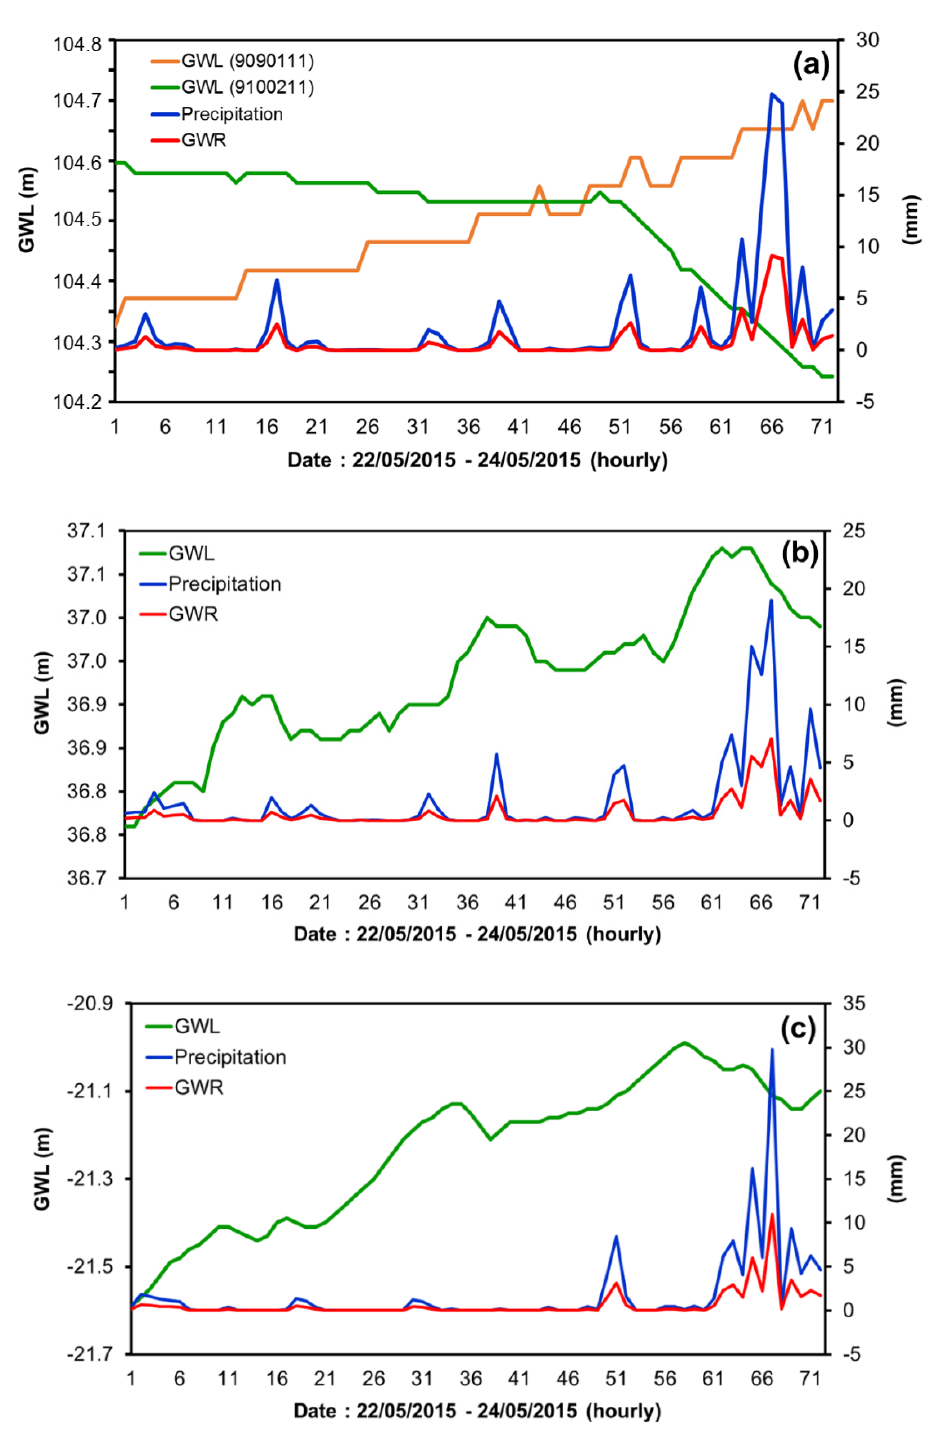
Figure 11. Time series of hourly GWL versus precipitation for a continuous rain event from 22 May 2015 to 24 May 2015: ( a ) the well locations in the east (Well 9100211) and in the west (well 9090111) of the proximal fan (see Figure 1 for the details of the well locations), ( b ) the well location (well 1004011) in the middle fan, and ( c ) the well location (9180211) in the distal fan. Note that the recharge calculation is based on the Composite Curve Number (CCN) method, and the recharge at the well locations was extracted for presentation purposes.